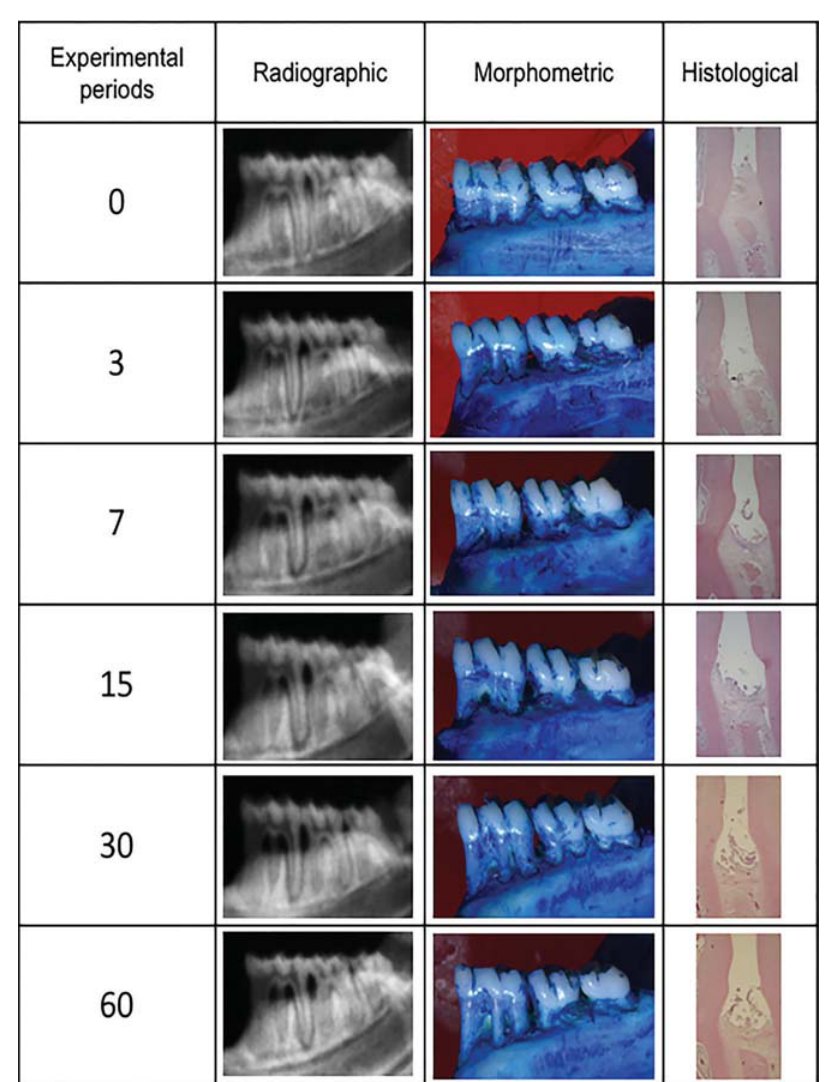
Figure 3- Analysis methodology (radiographic, morphometric and histologic) in different induction